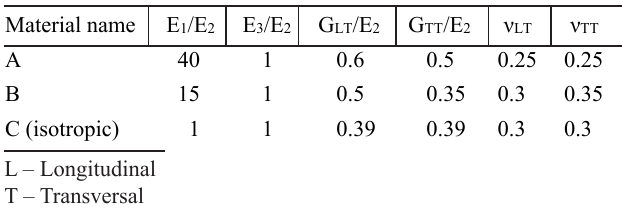
Table 1. Mechanical properties of materials